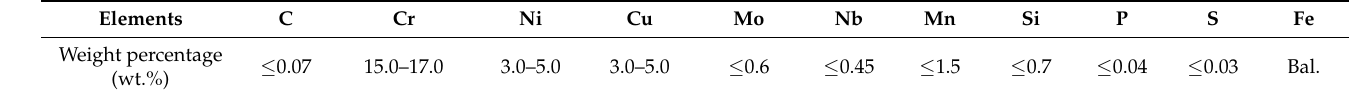
Figure 1. ( a ) Surface morphology of the 17-4PH steel powder; ( b ) scheme of the tensile test specimens used for the SLM fabrication. Table 1. Chemical composition of the 17-4 PH steel powder (provided by EOS GmbH). Elements